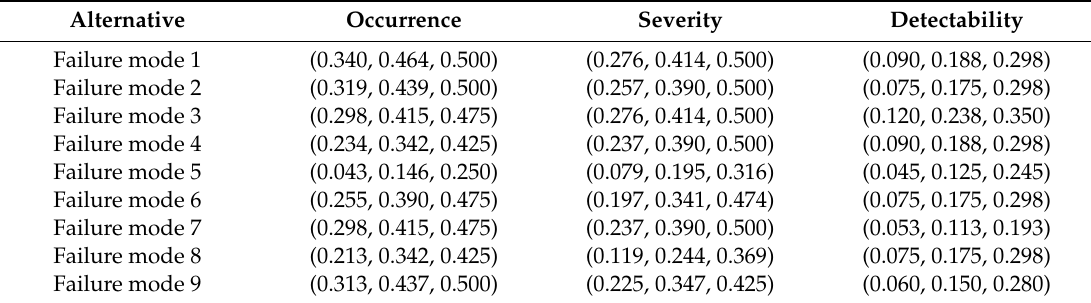
Table 20. Weighted normalized decision matrix.